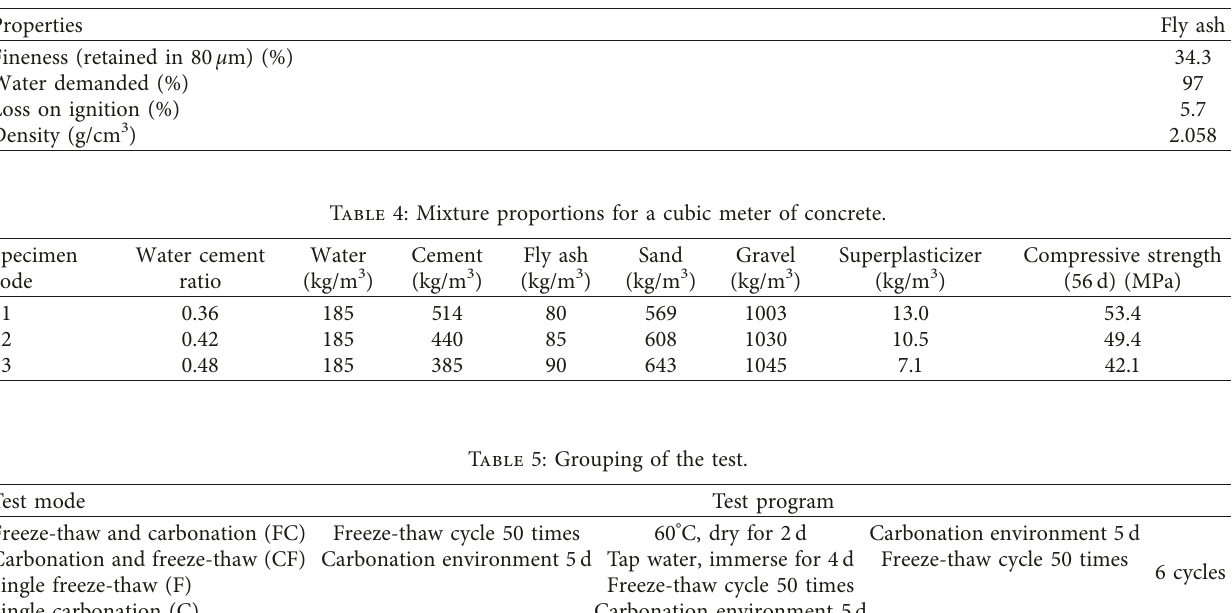
Table 3: Physical properties of Class III fly